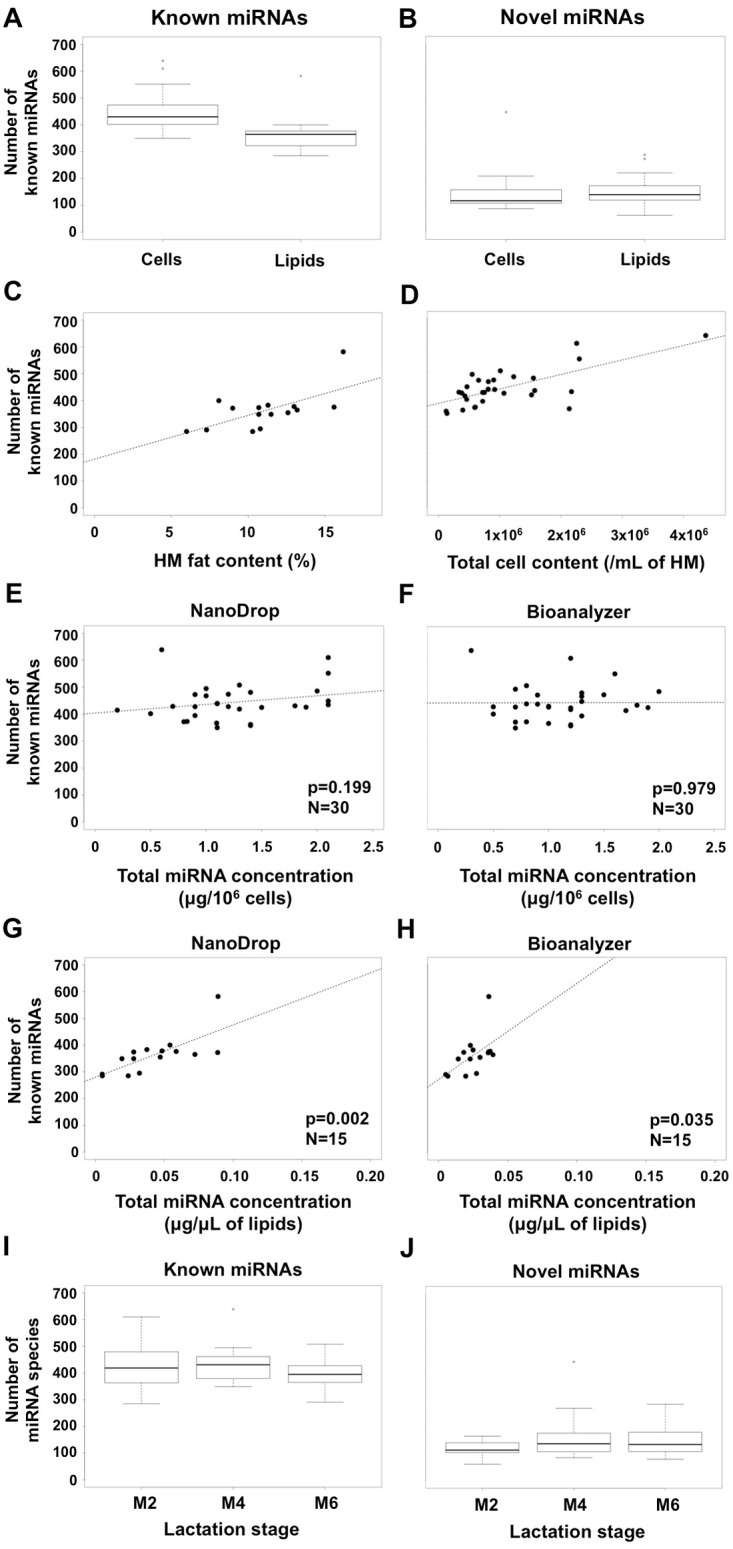
(A, B) The number of (A) known and (B) novel miRNA species in HM cells (n = 30) and lipids (n = 15). (C) Relationship between the number of known miRNA species profiled in milk lipids (n = 15) and total fat content. (D) Relationship between the number of known miRNA species profiled in milk cells (n = 30) and total cell content. (E, F) Relationship between total known miRNA species profiled in HM cells and total HM cell miRNA concentration (μg/106 cells) measured by Nanodrop (E) and Bioanalyzer (F). (G, H) Relationship between total known miRNA species profiled in HM lipids and total HM lipid miRNA concentration (μg/μL of lipids) measured by Nanodrop (G) and Bioanalyzer (H). (I, J) Number of (I) known and (J) novel miRNA species identified in the three stages of lactation examined (n = 10).